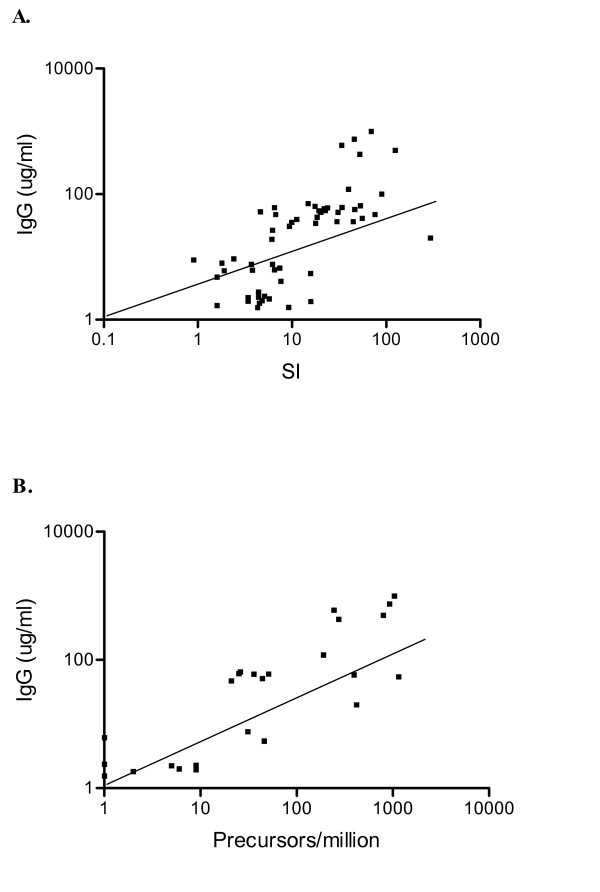
Antibody immunity to both foreign and tumor antigens is an indicator of a concomitant T cell response. Results from the (A) proliferation assay and (B) ELISPOT assay for antigens HER-2/neu, tt and CMV are plotted on the log-scaled horizontal axis. Antigen specific IgG antibody responses are plotted on the log-scaled vertical axis. The diagonal line indicates line of regression.